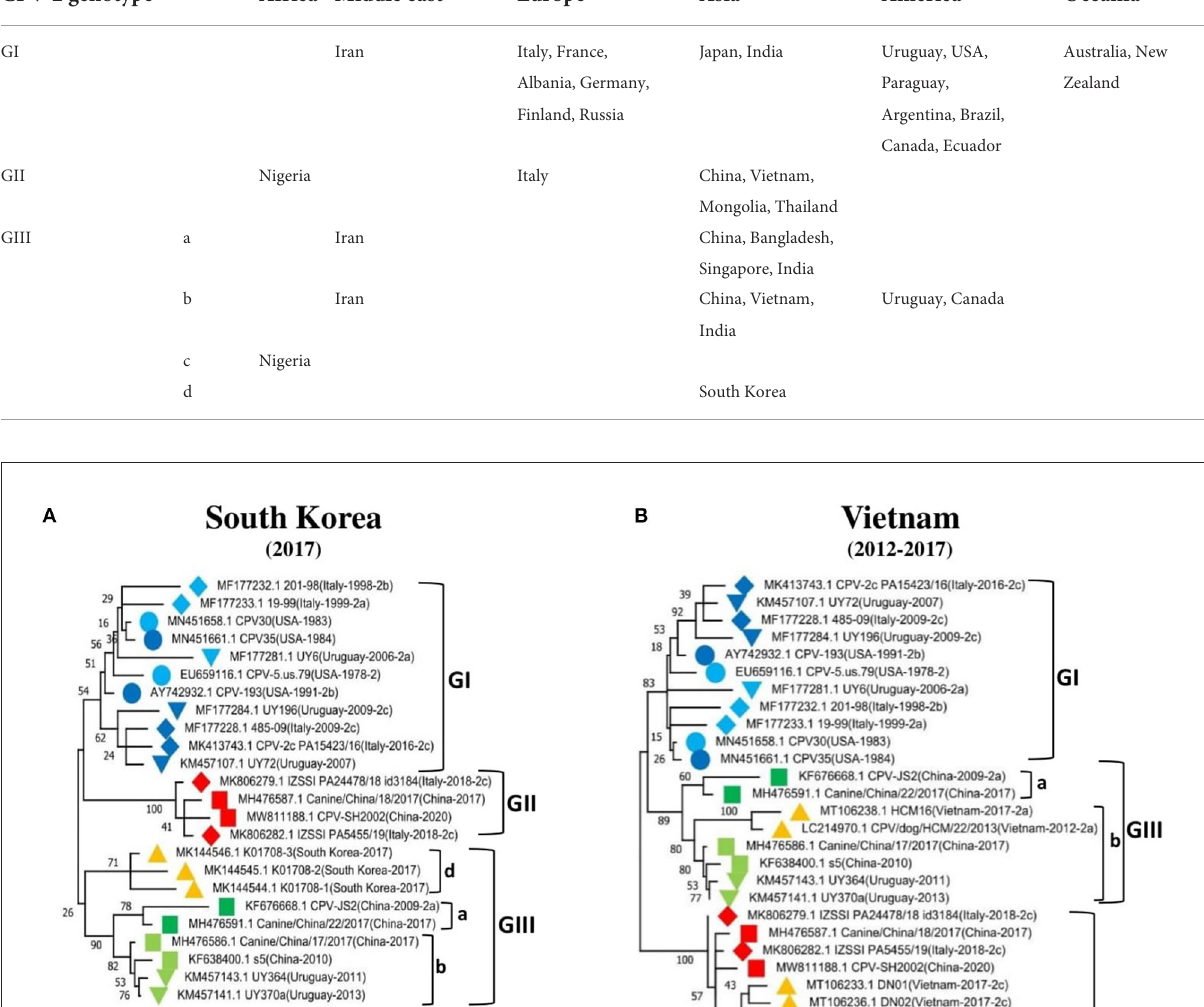
geographic area and helped to properly understand the spread of CPV-2 at a local level and in all continents. The